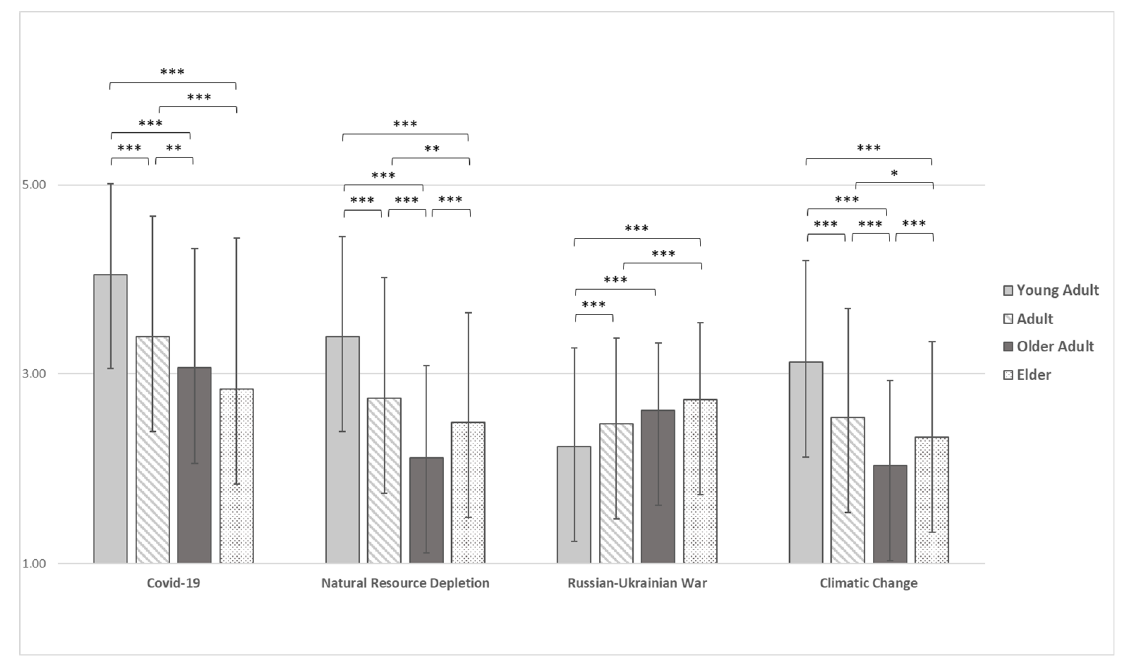
Figure 2. Differences among age groups for COVID-19, Natural Resources Depletion, Russia-Ukraine War, and Climatic Change related habits changes. Note. * = p < 0.05, ** = p < 0.01, *** = p < 0.001.